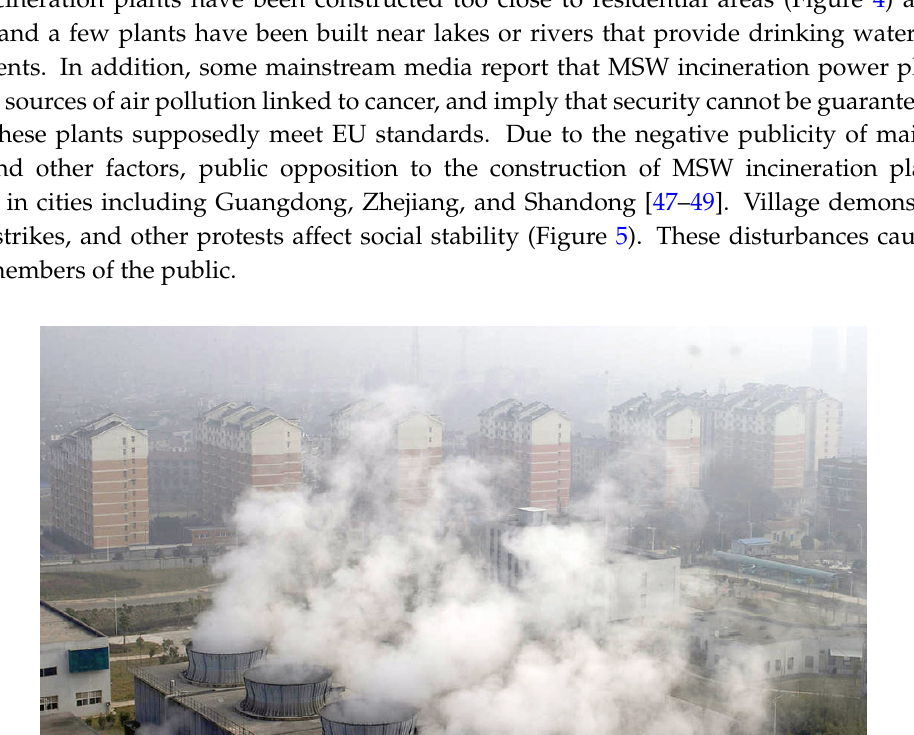
Figure 5. Protests against WTE incineration in China (photos source: [49]). The second reason for opposition to the WTE incineration program is the lack of public participation. Sheery [51] concluded that public participation could be divided into eight levels (Figure 6). There was no public participation when the WTE incineration plants were first developed in China. As citizens’ environmental consciousness is being awakened, there is growing concern about the construction of WTE incineration plants. Since 2010, there have been some demonstrations against the construction of WTE incineration plants that have attracted the attention of the government. Consequently, some public consultations have been conducted prior to initiating construction of WTE facilities, but the public participation processes are regarded as tokenism, which is far removed from involvement at the level of citizen power.